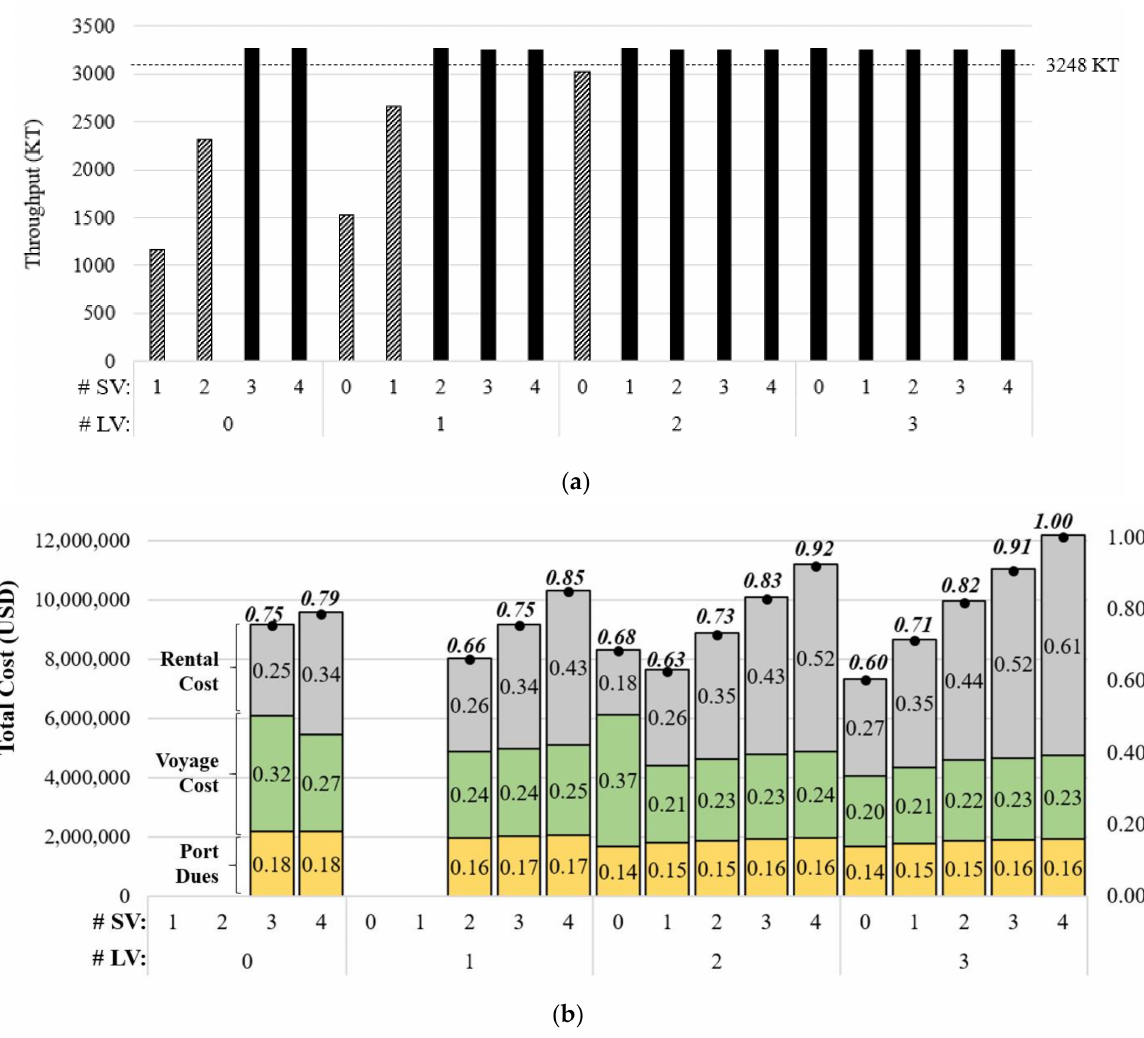
Figure 4. Impact of the number of vessels at the current voyage speed under FAFU (case C2): ( a ) transported volume; ( b ) cost